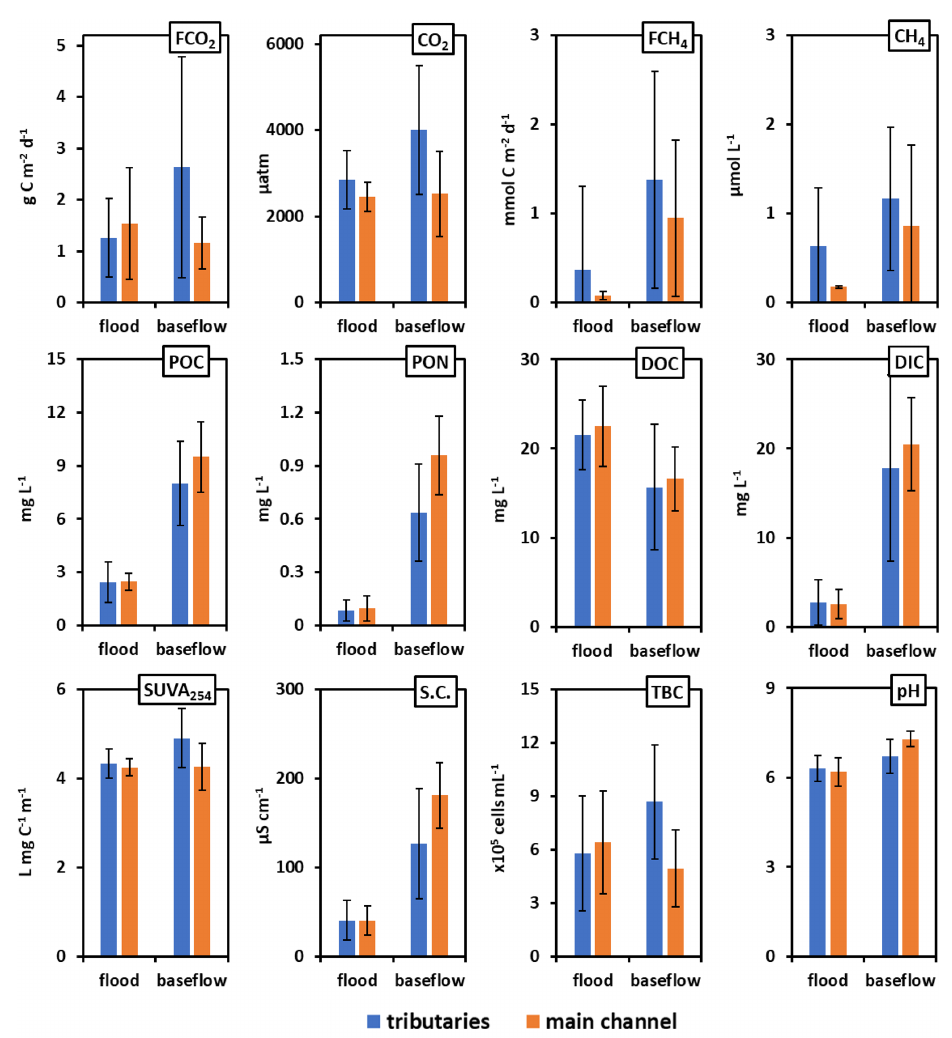
Figure 3. Mean ( ± SD) GHG concentration and chamber-measured fluxes ( F CO 2 ), hydrochemical parameters, particulate organic carbon and nitrogen (POC and PON, respectively) and total bacteria count (TBC) in the main channel (orange column) and the tributaries (blue column) of the Ket River in spring flood and summer (early fall)